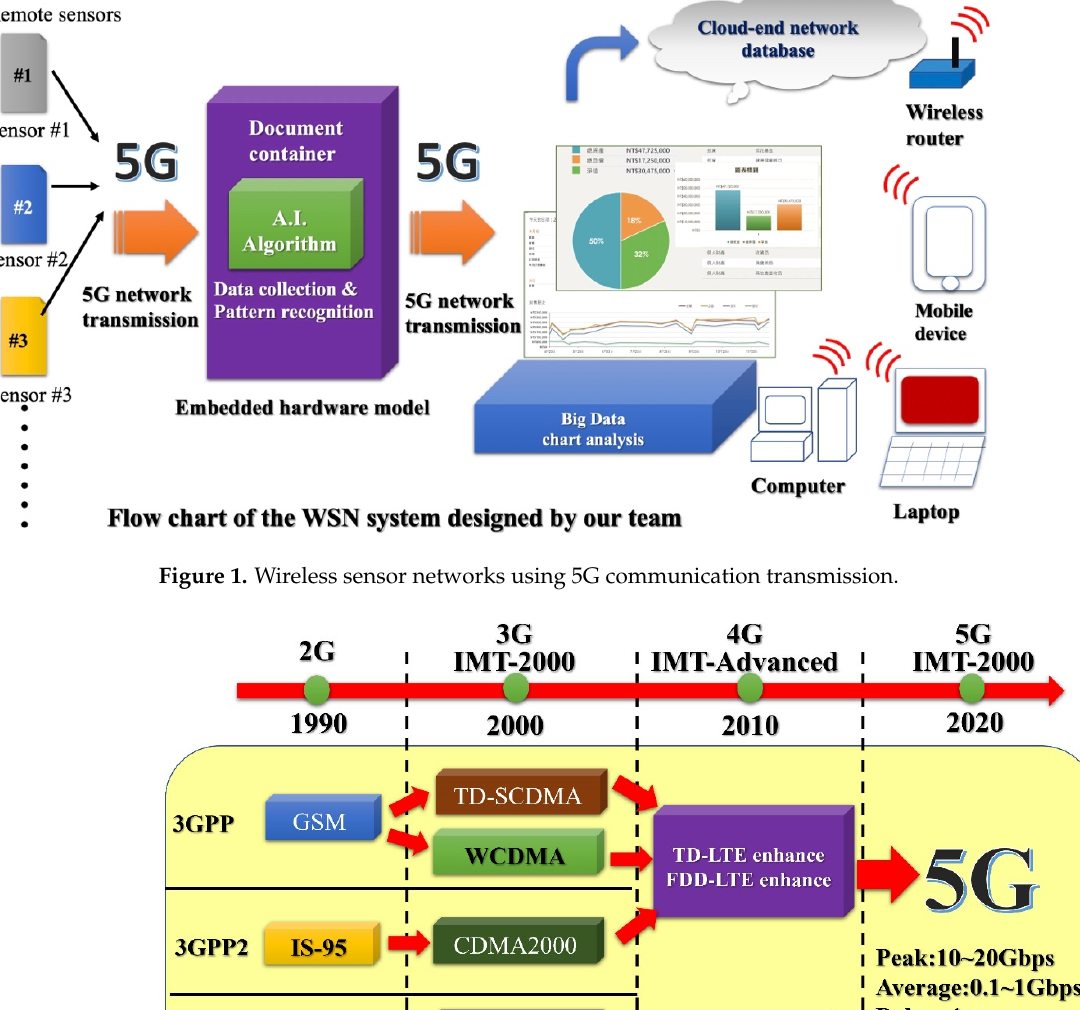
Table 1. Abbreviated terms used in this paper are compared with full names.